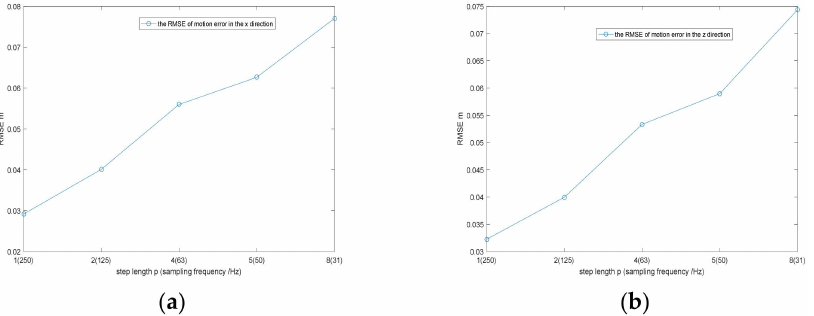
Figure 12. ( a ) Variation in the RMSEs with different step lengths in the x direction (airborne SAR data experiments); ( b ) Variation in the RMSEs with different step lengths in the z direction (airborne SAR data experiments).